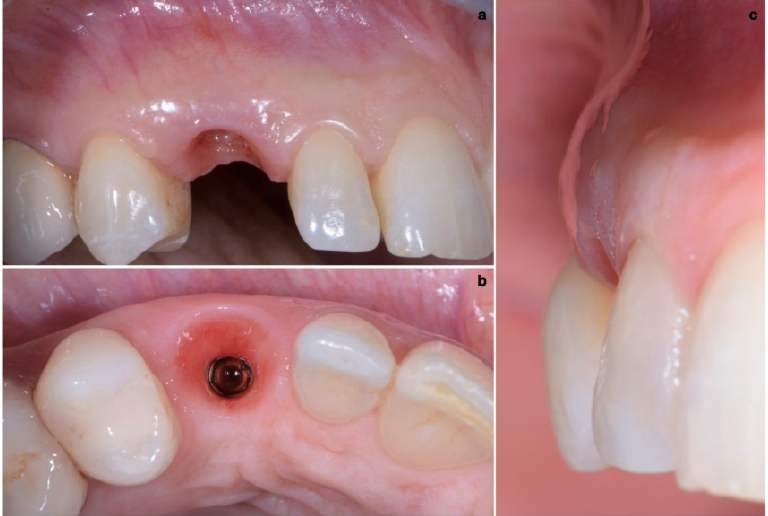
Figure 14. ( a – c ) Conclusion of the conditioning phase.